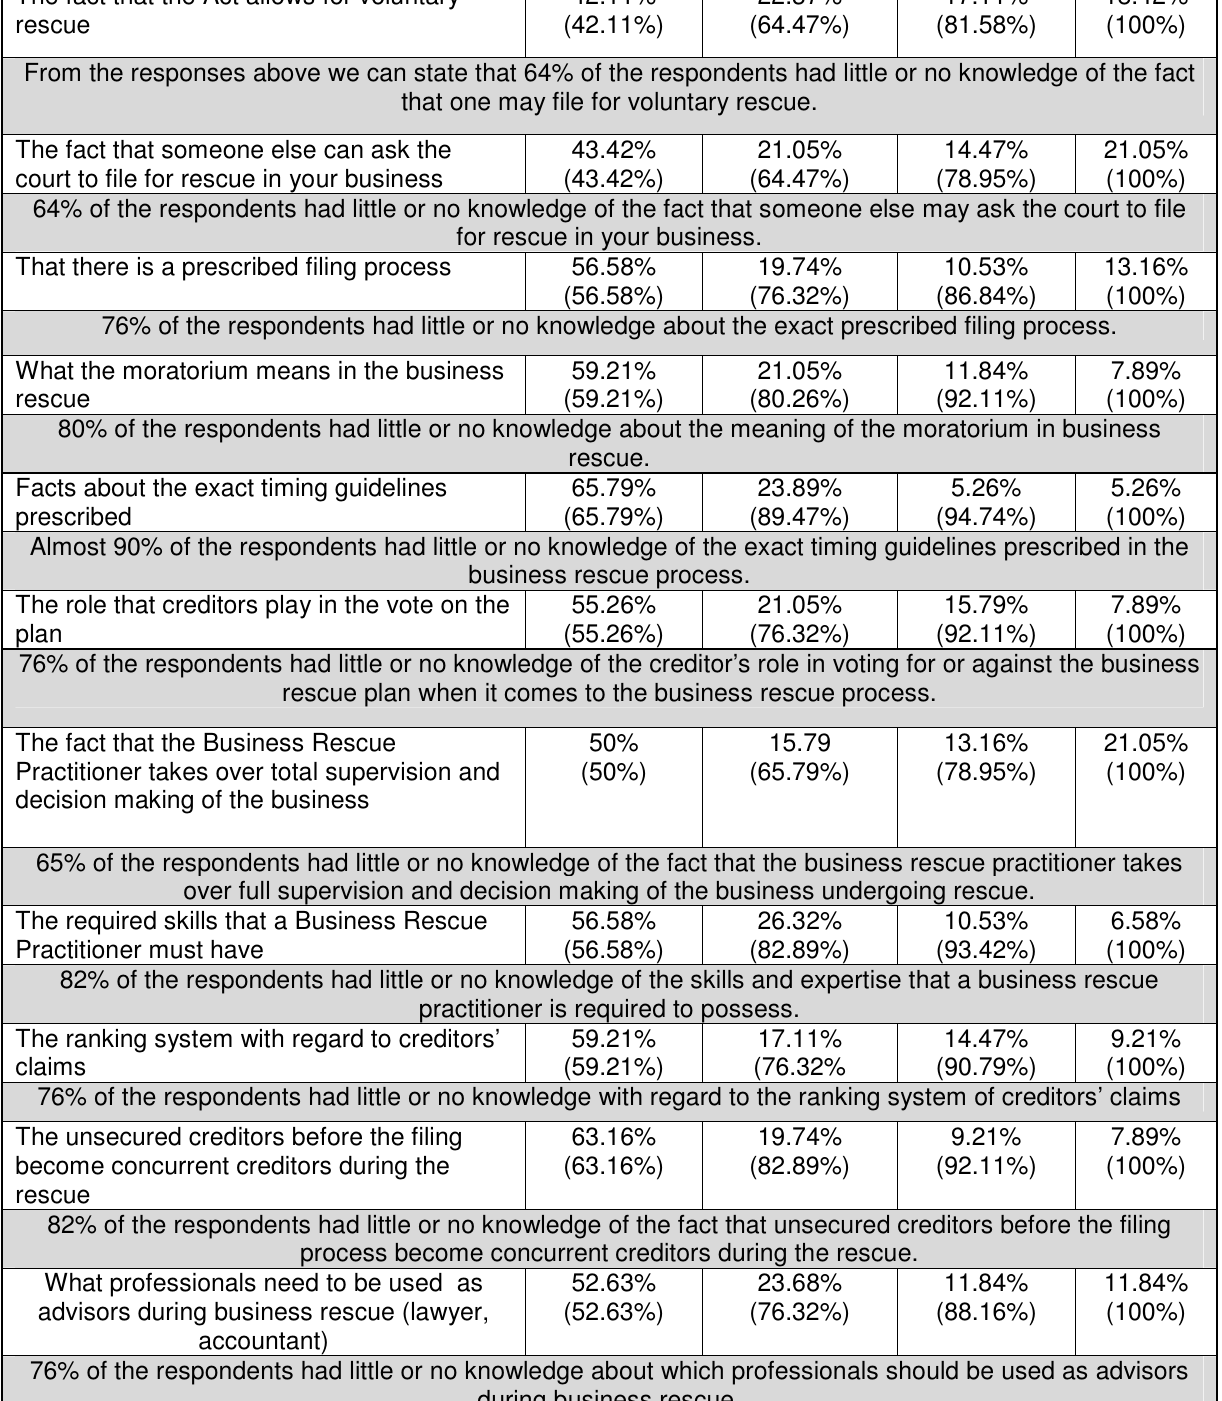
Table 7: Knowledge about relevant elements in the Companies Act no 71 of 2008 Knowledge component None at all Low Medium High Cumulative